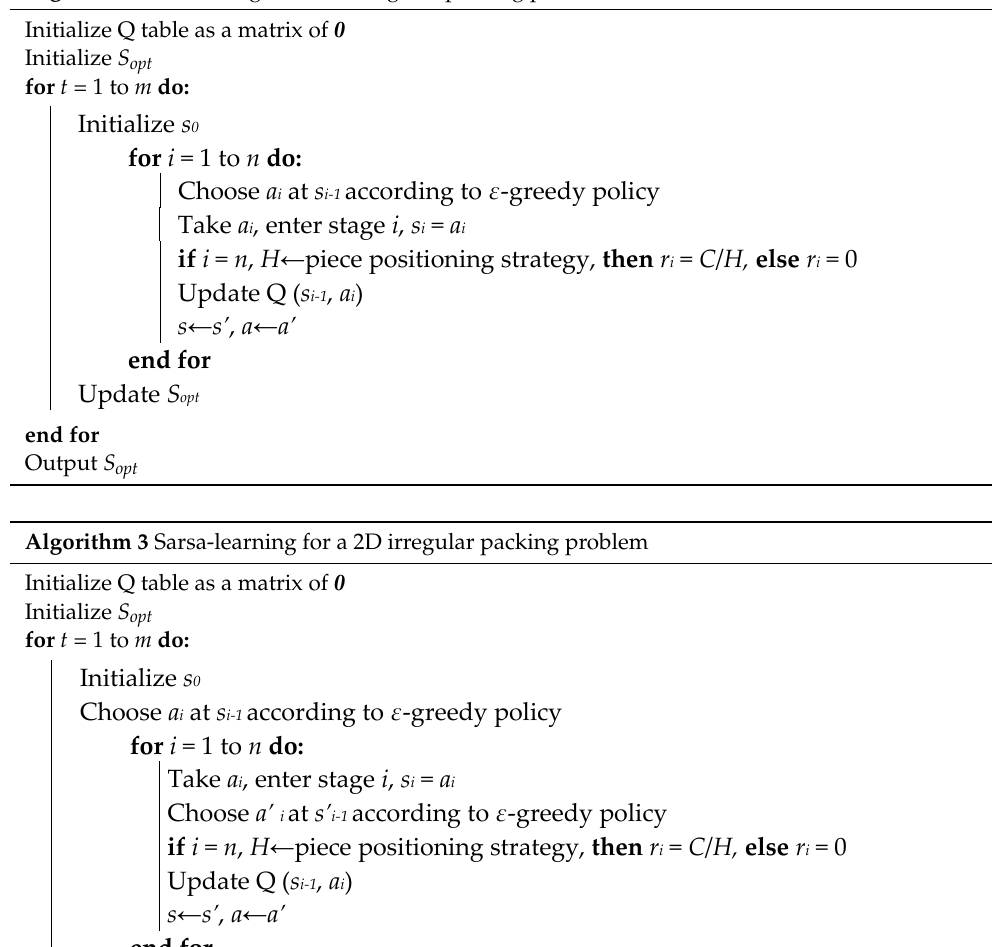
Figure 7. The process of the hybrid RL algorithm for 2D irregular-piece packing. Algorithm 2 Q-learning for a 2D irregular packing problem Algorithm 2 Q-learning for a 2D irregular packing problem